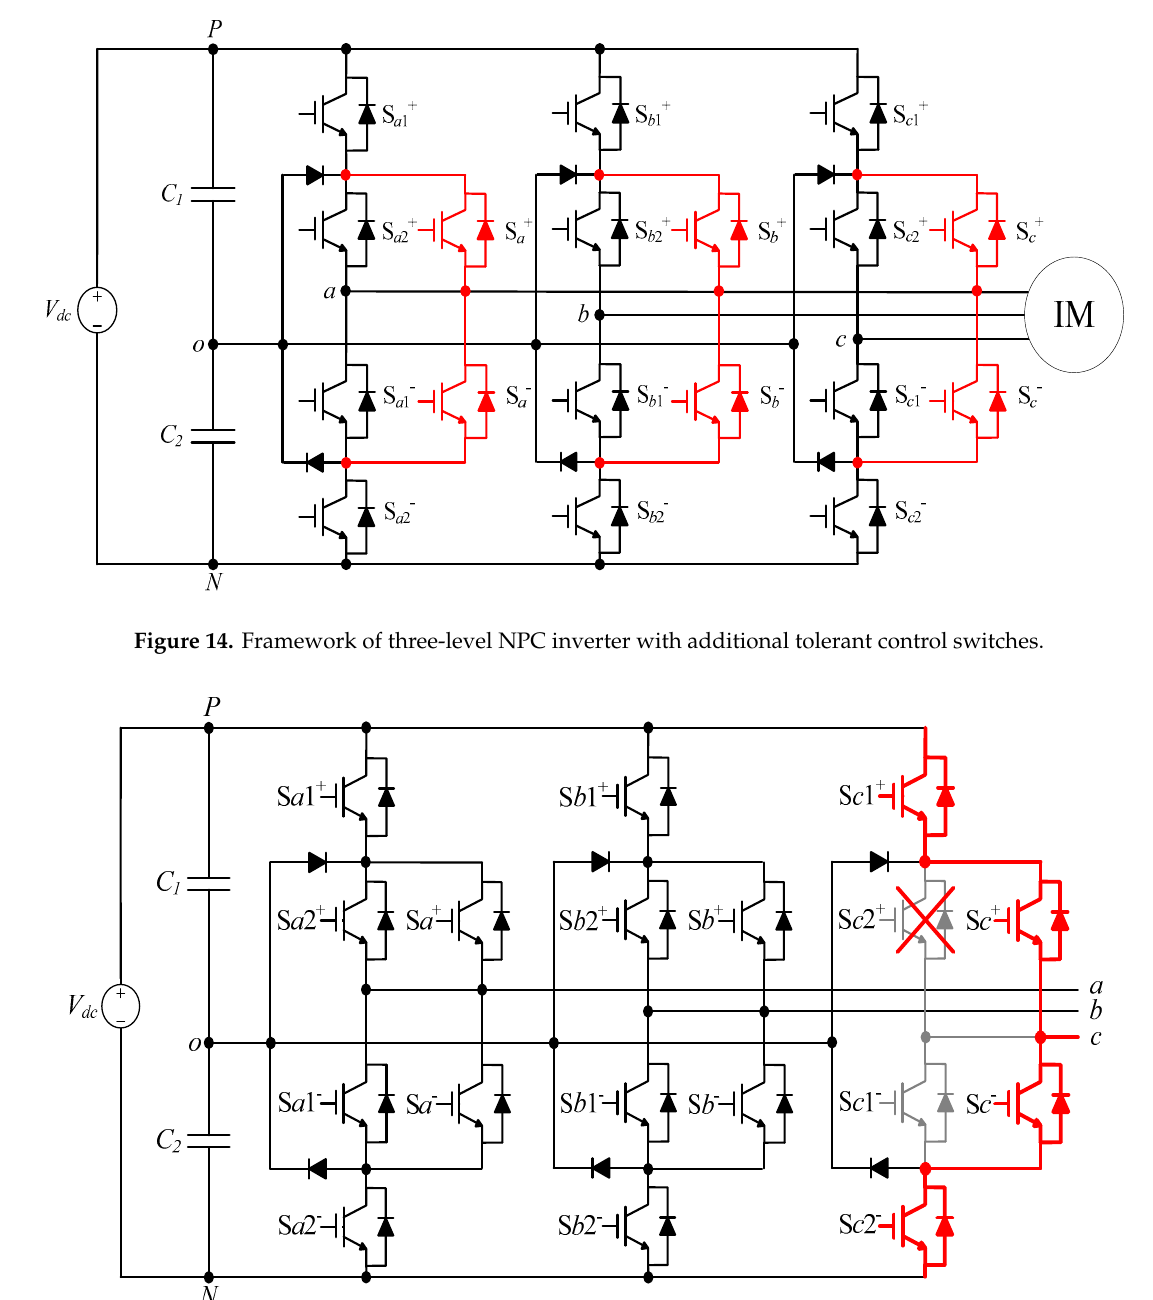
Figure 15. The fault-tolerant control for the occurrence of an open-circuit fault in S c 2 + .